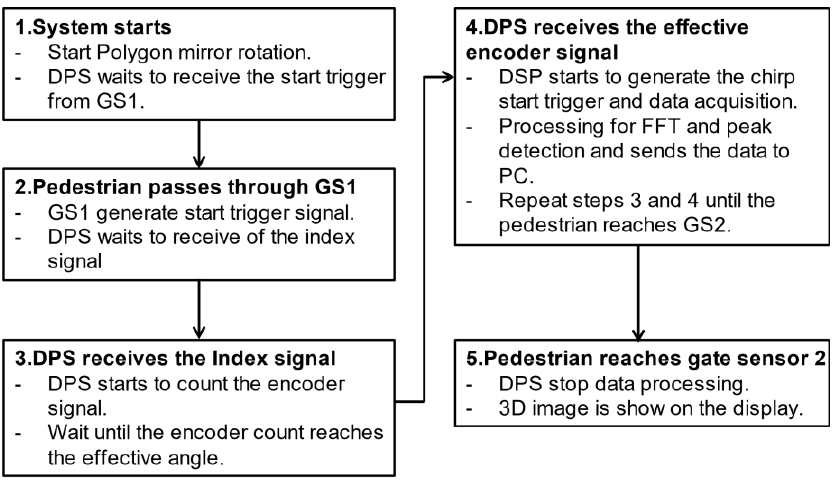
Figure 8. Flow of data acquisition.